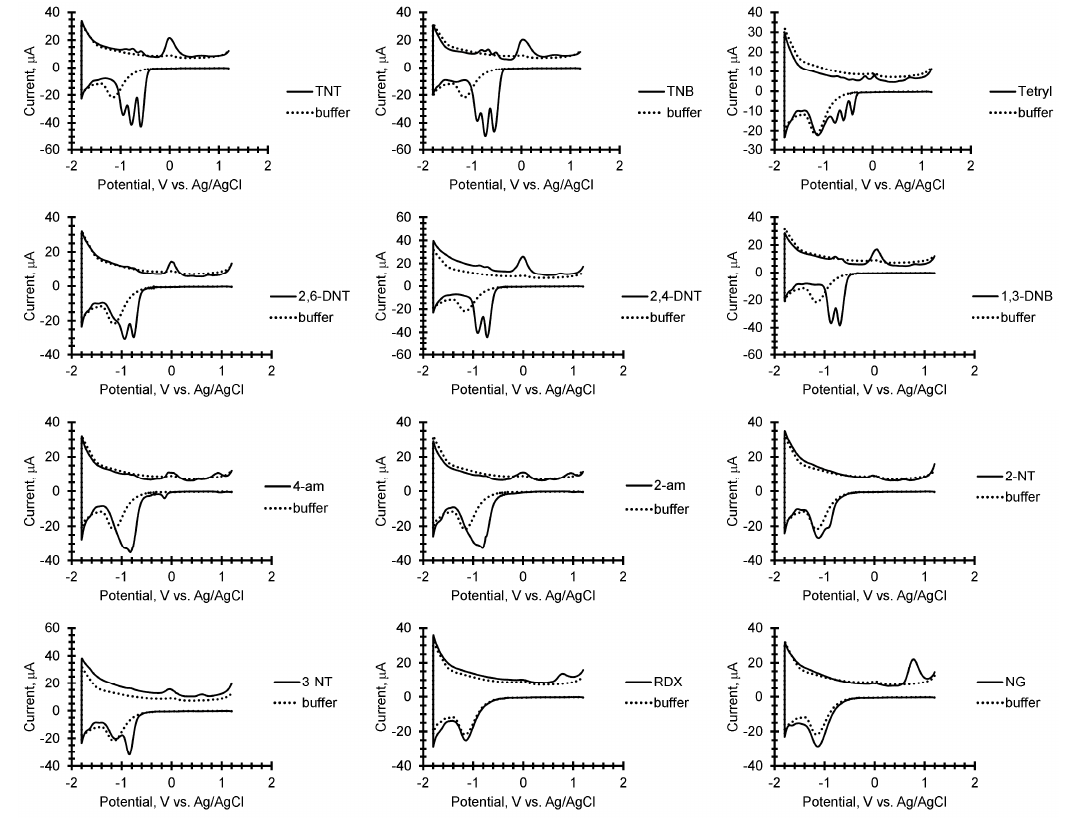
Figure 2. Cyclic square wave voltammetry (CSW) library. The CSWs were recorded at a frequency =17.5 Hz, amplitude =25 mV, current range =2 mA, and potential range =1.2 V to − 1.8 V vs. Ag/AgCl with two 1-min accumulation steps at 1.2 V and − 1.8 V.